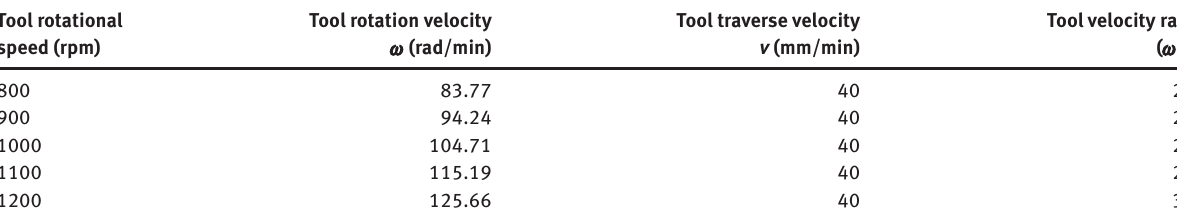
Table 2: Tool velocity